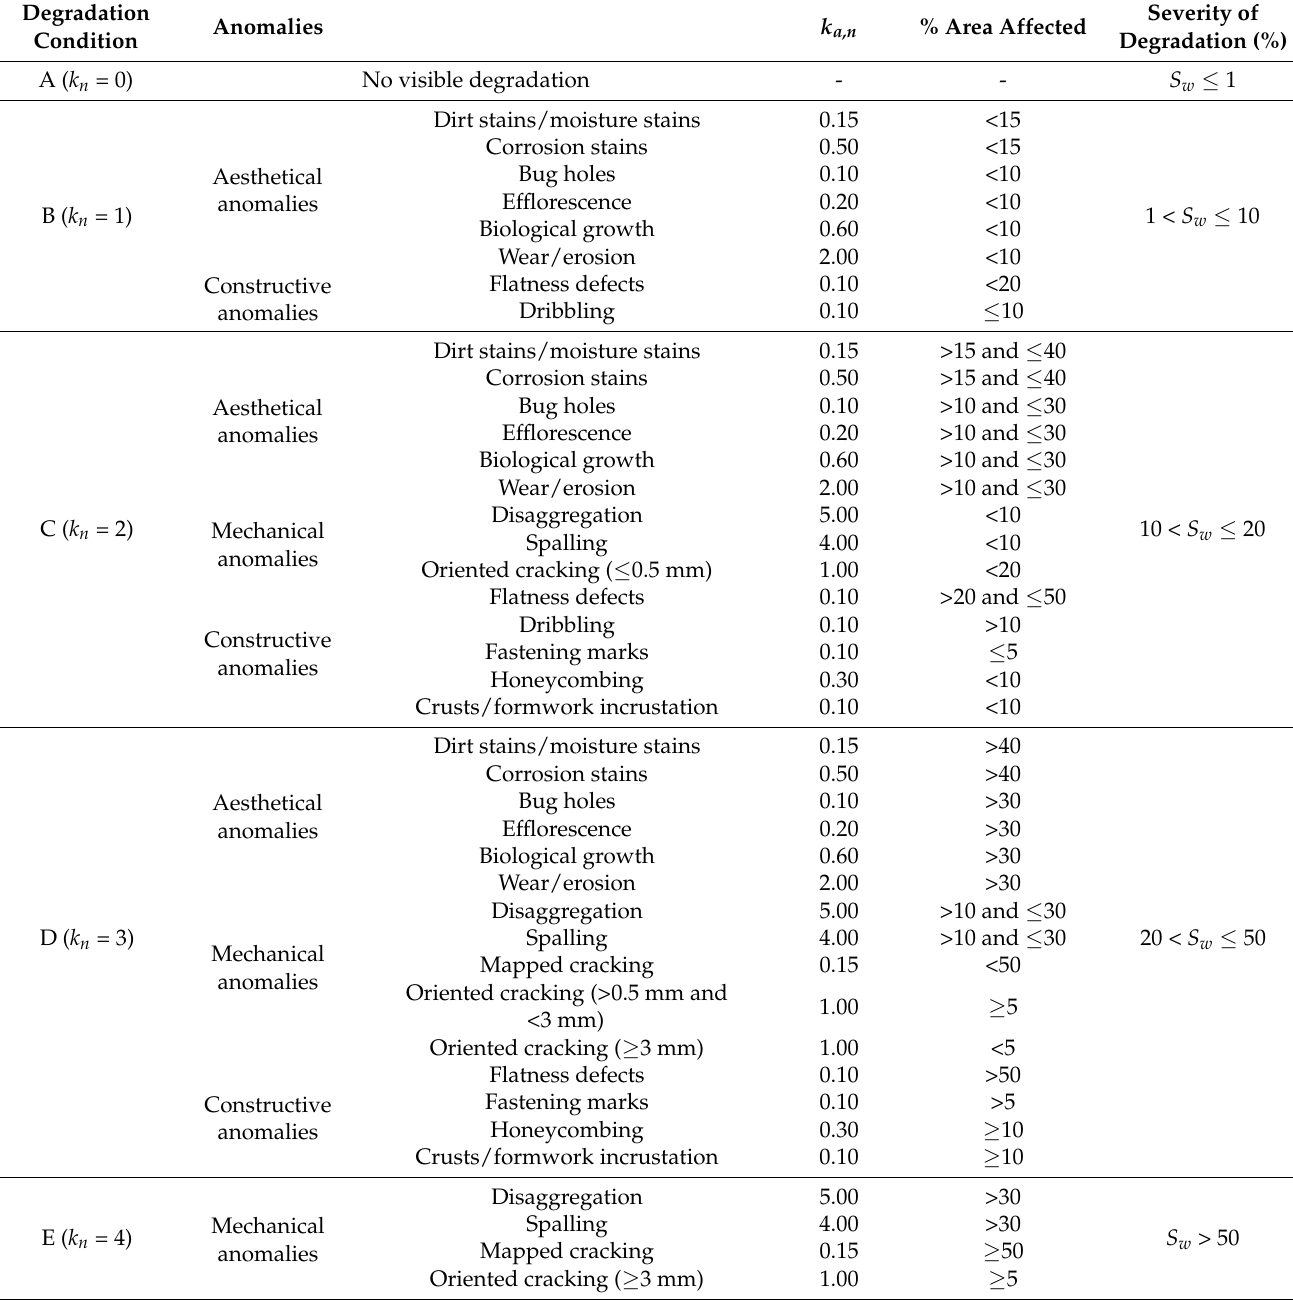
Table A4. Classification system for architectural concrete façades (ACF)